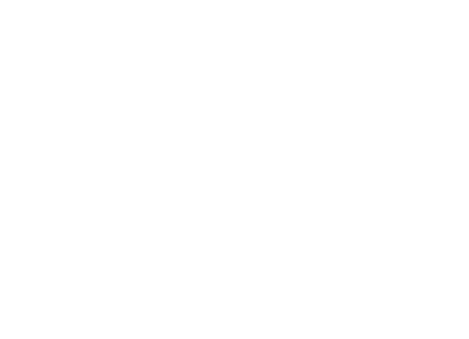
spiro-OMeTAD are taken from the references 26–28 . The blue shaded area of Fig. 1c manifests the absorption spec- tra of PSK in the structure. It is clear that the perovskite layer can only absorb sunlight over 300–800 nm due to its bandgap (1.55 eV), so all NIR light is wasted. To push light absorption beyond the visible range, an ultrathin MoTe 2 layer is placed below the perovskite film. The bulk MoTe 2 semiconductor endowed with a small indirect bandgap of about 1.0 eV 29 is able to extend light absorption to wavelengths up to 1200 nm, as is indicated by the pink shaded region of Fig. 1c. Besides an indirect bandgap, the bulk MoTe 2 enjoys two dominant direct excitonic gaps, termed A and B, around 1.2 and 1.5 eV, respectively 30,31 , which specify its absorption peaks, as appeared in